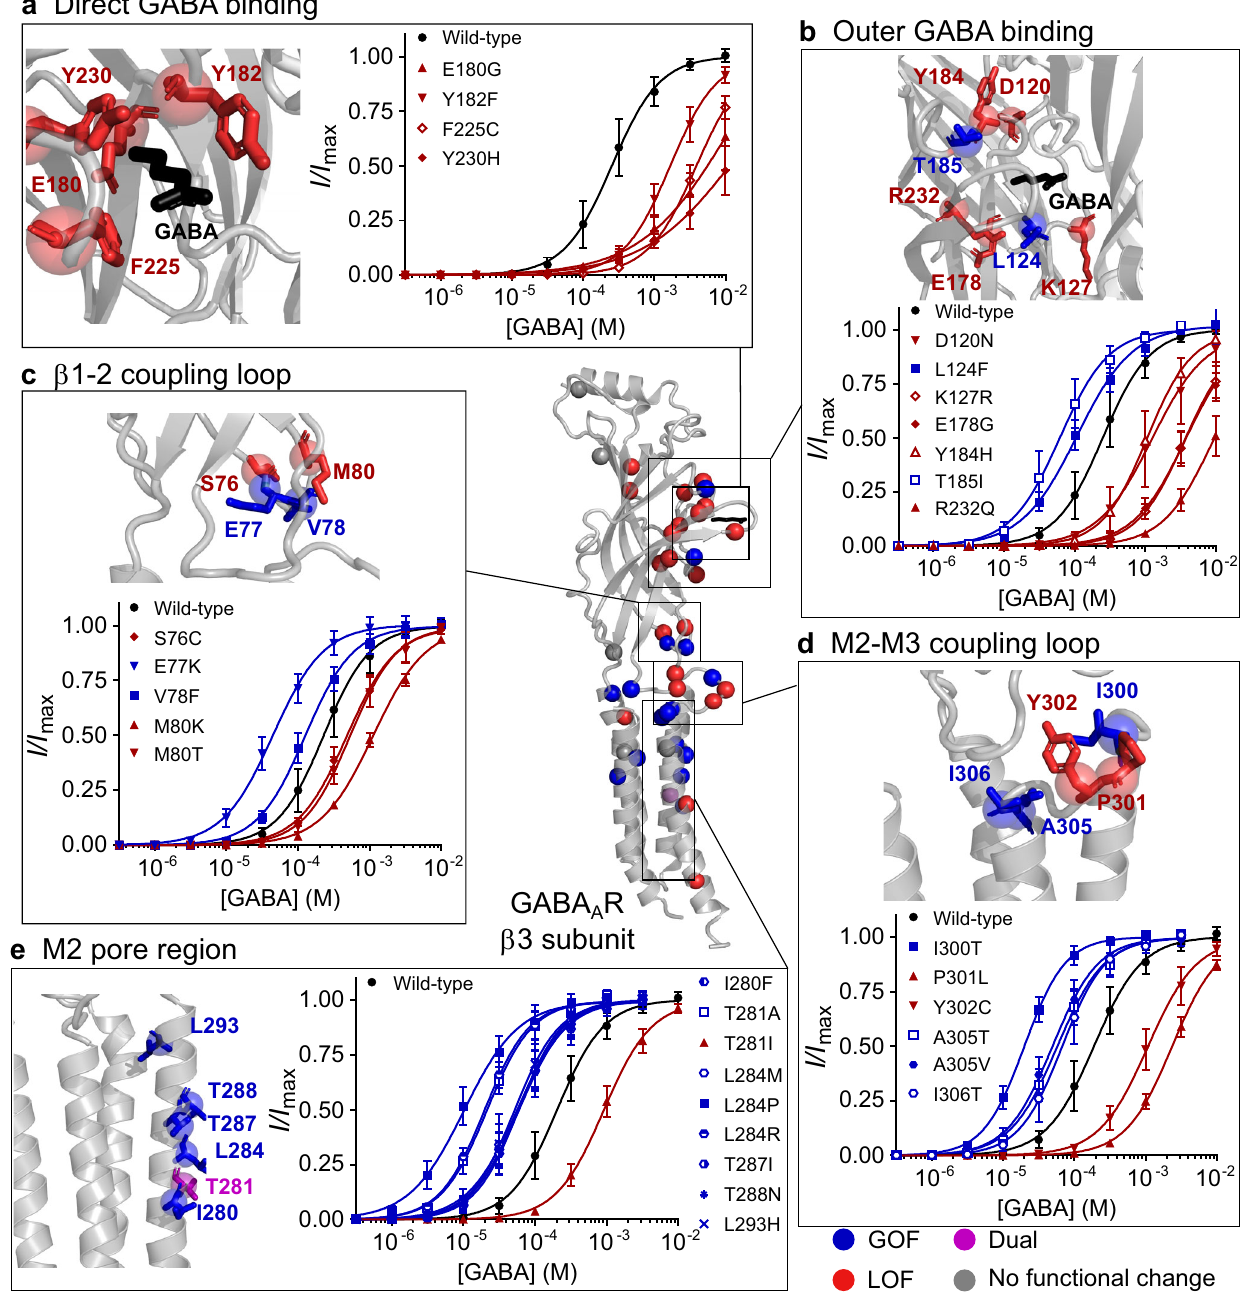
Fig. 7 3D structural map and concentration – response curves. 3D structure of GABA A receptor β 3 subunit displaying the location of: gain-of-function (blue), loss-of-function (red) and dual (purple) variants, with the variants showing no functional change in grey. a – e Structure of the β 3 subunit with the backbone coloured in grey and a close-up view of residues a directly binding GABA; b in the outer shell of GABA binding; c β 1-2 coupling loop; d M2-M3 coupling loop and e M2 region with amino acid sidechains of residues containing variants in sticks. Red indicates loss-of-function, blue indicates gain-of- function variants and GABA is in black. Concentration – response curves for variants directly binding GABA. Dots represent mean ± s.d. and lines the fi tted Hill equation. Wild-type concentration – response curves run on the same days as the variants are shown in black. Red indicates loss-of-function and blue indicates gain. For each panel, a n = 35, 12, 11, 12, 12 independent experiments at wild-type, E180G, Y182F, F225C, Y230H; b n = 34, 11, 12, 14, 13, 11, 13, 14 at wild-type, D120N, L124F, K127R, E178G, Y184H, T185I, R232Q; c n = 34, 12, 11, 12, 11, 10 at wild-type, S76C, E77K, V78F, M80K, M80T; d n = 36, 15, 11, 12, 10, 10, 24 at wild-type, I300T, P301L, Y302C, A305T, A305V, I306T; e n = 57, 12, 14, 11, 11, 12, 12, 11, 11, 11 at wild-type, I280F, T281A, T281I,